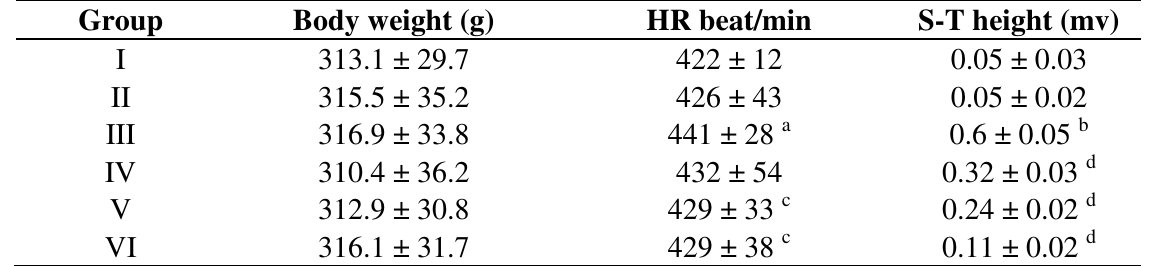
Table 1. Effect of GBE50 on heart rate and S-T height in rats.